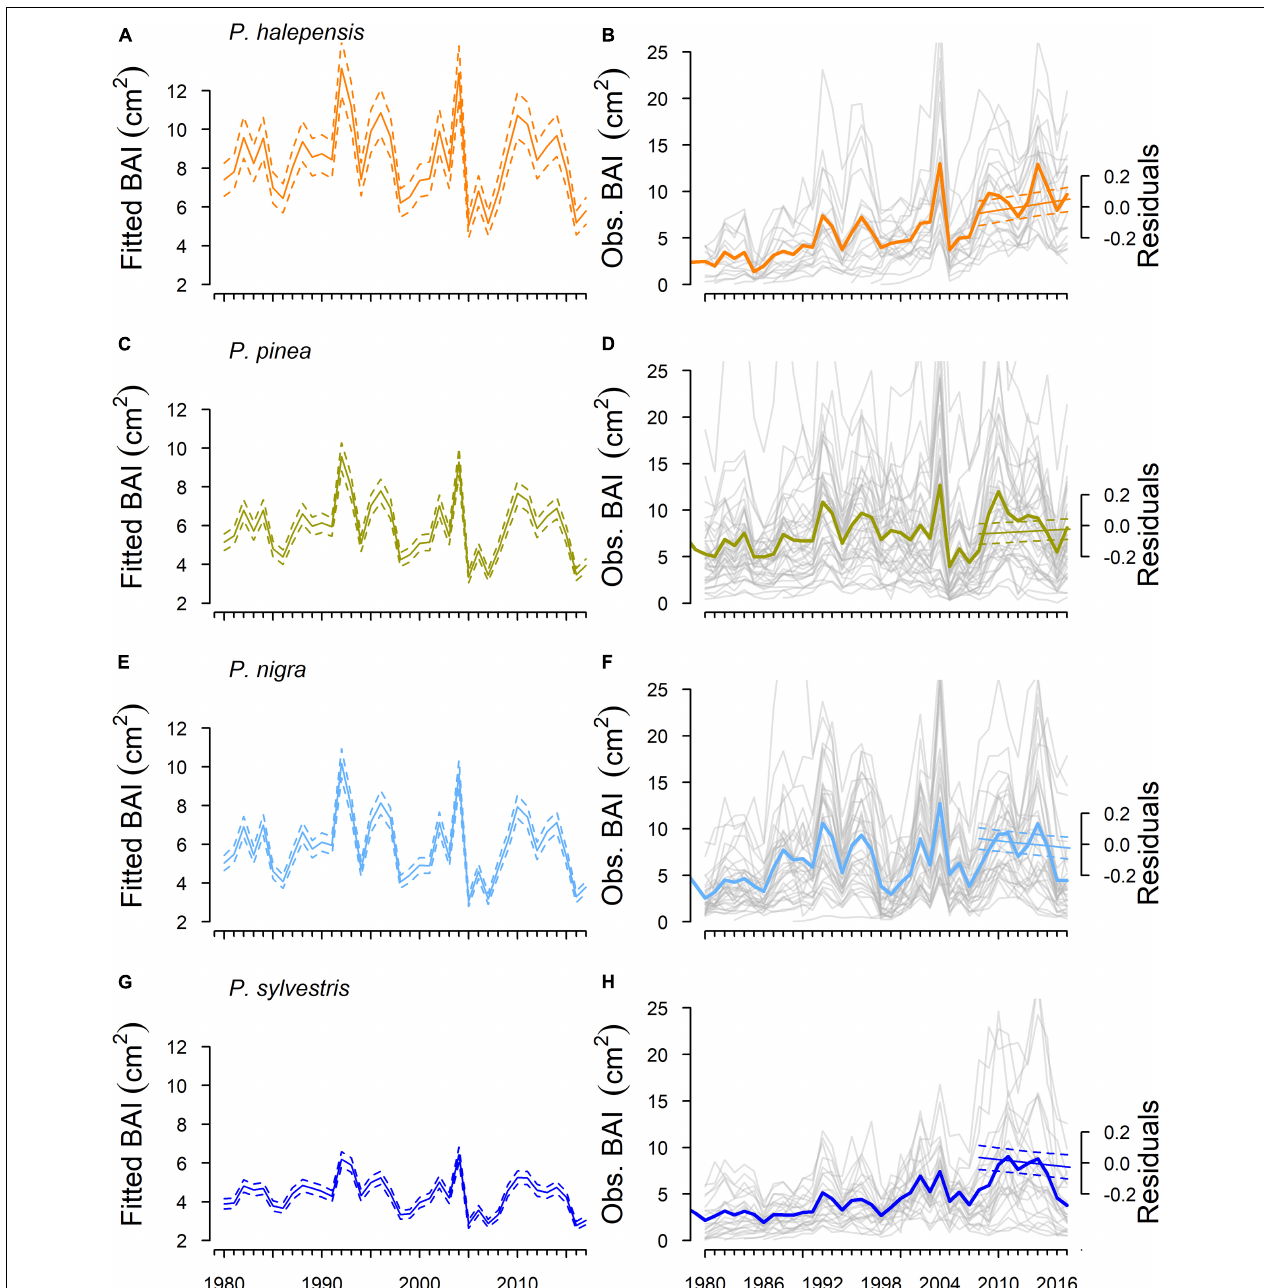
FIGURE 4 | Expected and observed growth (BAI) for each pine species. Panels (A,C,E,G) show the predicted growth pattern (solid and dashed lines represent main effect and 95% confidence intervals, respectively) including the SPEI*species interaction while keeping age constant (mean age standardized = 0; ∼ 30 years). Panels (B,D,F,H) show the observed growth trajectories considering the common period 1980–2017. Gray lines represent the observations for each individual tree. Straight lines in the period 2008–2017 (secondary y -axis) represent the expected growth trends after accounting for age- and SPEI-effects (solid and dashed lines represent main effect and 95% confidence intervals, respectively). The positive trend in the residuals means that the model underpredicts observed growth trends during the studied